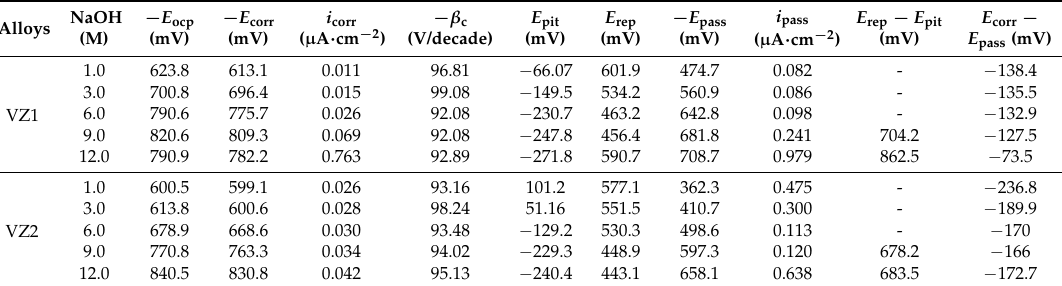
Table 2. The corrosion kinetic parameters obtained from CP technique (cyclic polarization) for the VZ1 and VZ2 alloys as a function of NaOH concentration at 27 ◦ C. NaOH Alloys (M)